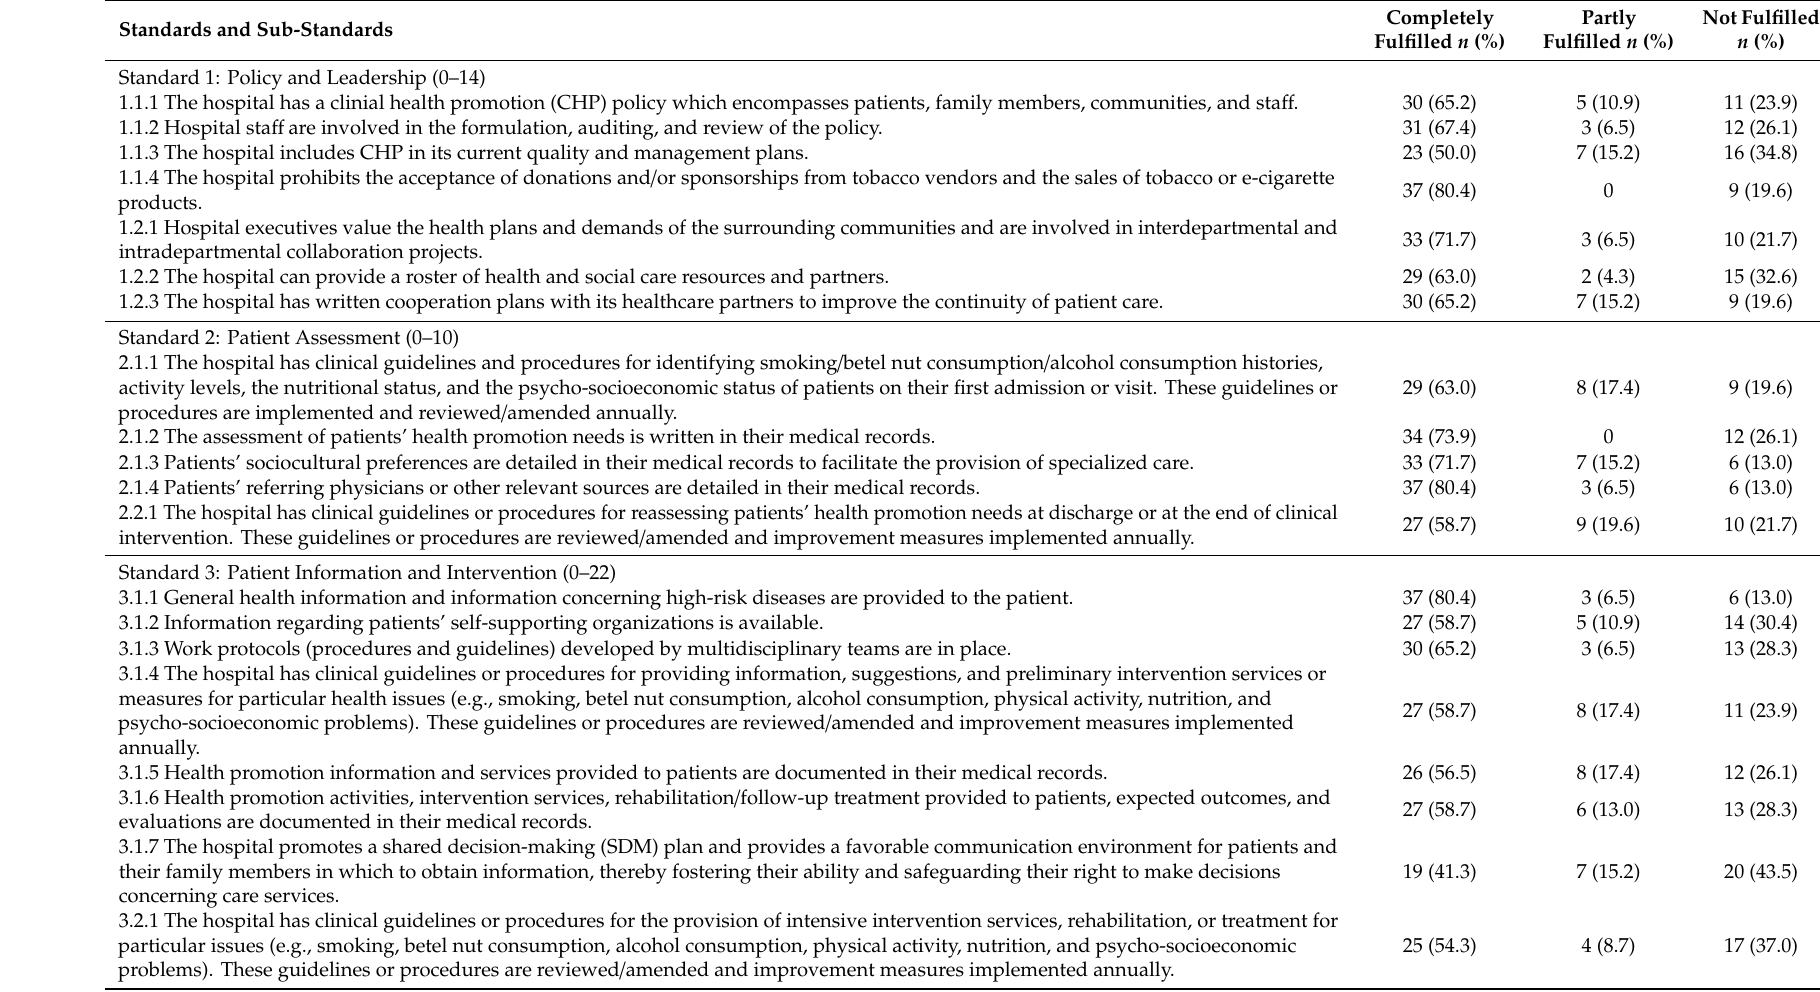
Table 1. Assessed compliance of the